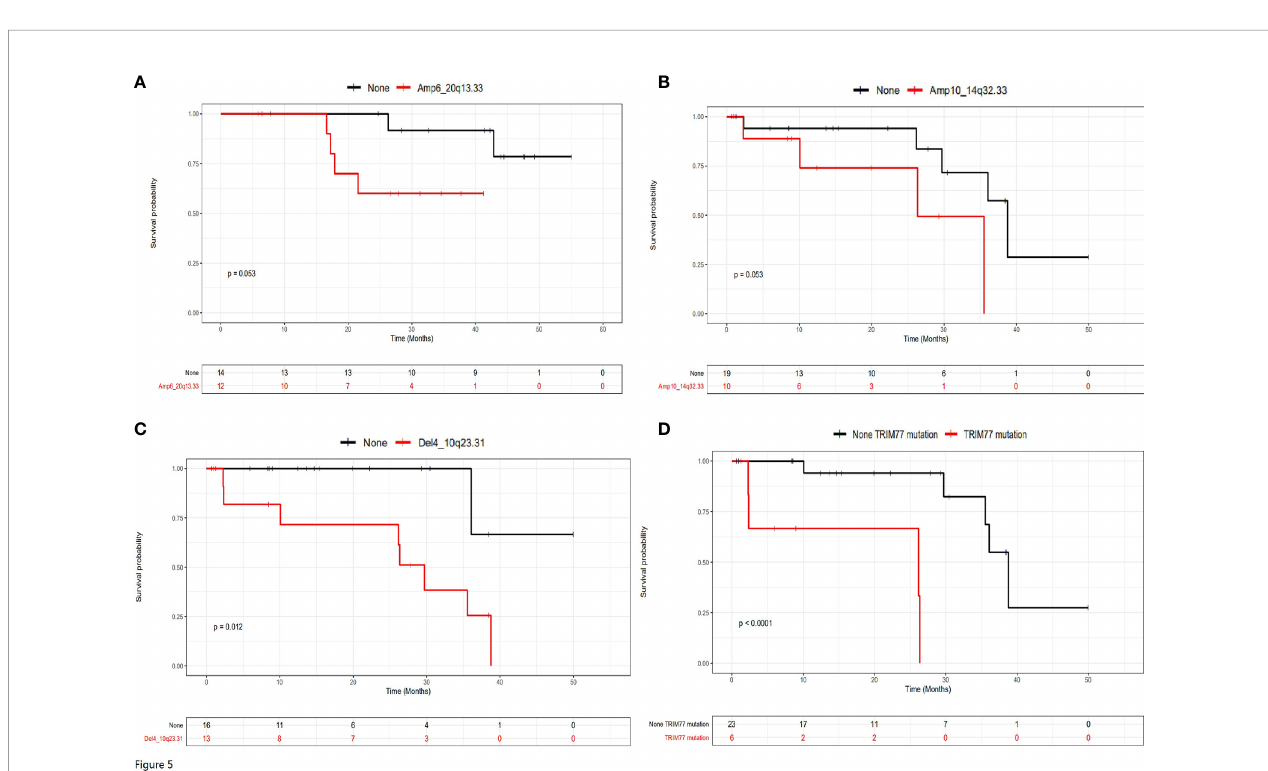
FIGURE 5 | The prognostic genetic variations for patients with or without liver metastasis. (A) Amp6_20q13.33 was the only signi fi cant prognostic genetic variation for patients without liver metastasis. (B – D) Amp10_14q32.33, Del4_10q23.31 and TRIM77 mutations were signi fi cant prognostic genetic variations for patients with liver